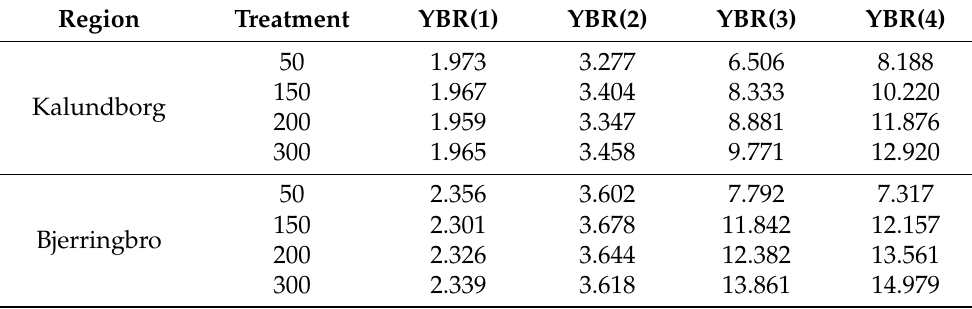
Table 1. Monthly YARA biomass readings (YBR) by region and